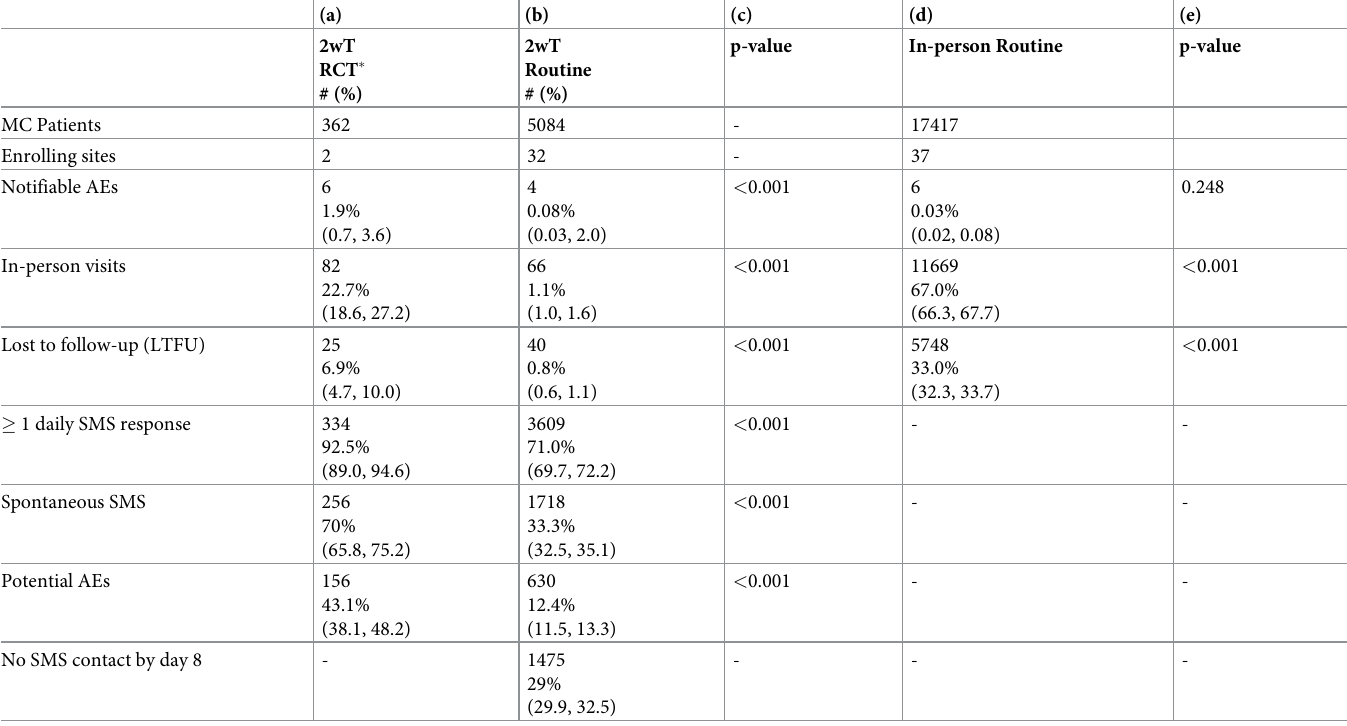
Table 2. Comparison of MC outcomes: 2wT RCT vs. 2wT routine; 2wT routine versus in-person